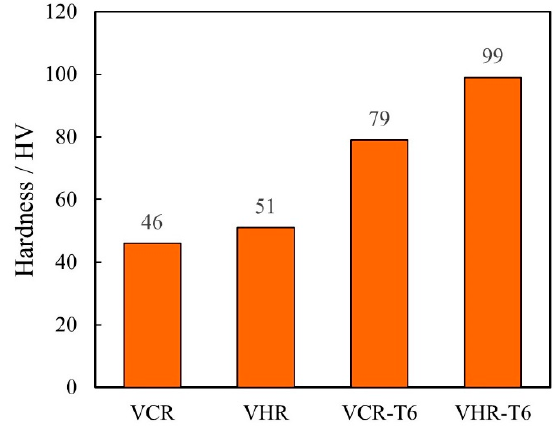
Figure 13. Comparison of hardness values.